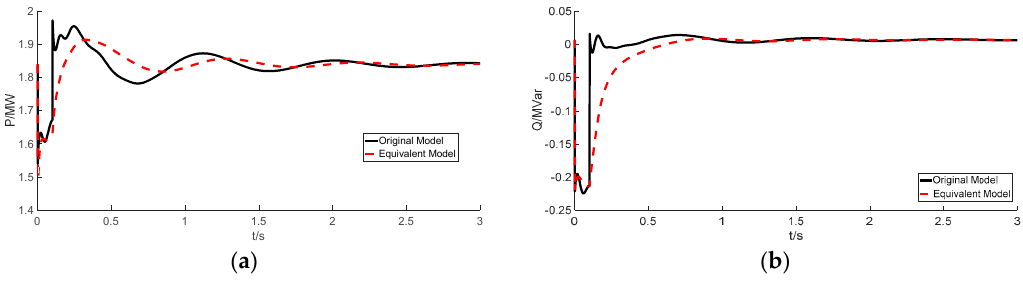
Figure 12. ( a ) Active and ( b ) reactive response under single phase grounded short circuit conditions.